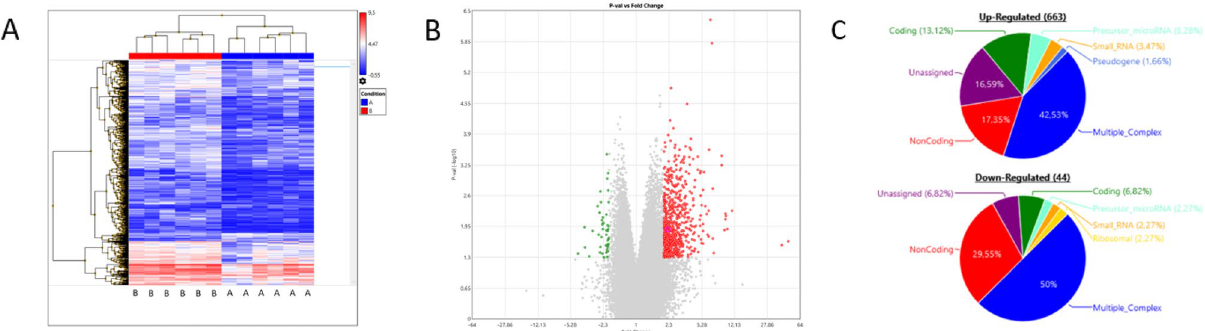
Figure 2. Transcriptome analysis of human embryos cultured in monophasic (5%) O 2 or biphasic (5%-2%) O 2 concentration. ( A ) Heat map. Group A (right part) includes six blastocysts cultured in monophasic (5%) O 2 concentration; Group B (left part) includes six blastocysts cultured in biphasic (5–2%) O 2 concentration. Upregulated genes are in red and downregulated genes are in blue. ( B ) Volcano plot. Each point represents one gene. On the X-axis, the fold change was calculated as the log2-ratio between the mean gene expression in embryos cultured in biphasic (5–2%) O 2 concentration and the mean gene expression in embryos cultured in monophasic (5%) O 2 concentration. Positive and negative values indicate the expression of genes which is higher in embryos cultured in biphasic (5–2%) and monophasic (5%) O 2 concentration, respectively. On the Y-axis, the statistical significance of the difference in gene expression between culture conditions is represented as the (− log10) of the P value. Red and green points mark differentially expressed genes. The thresholds of significance are − 2 and + 2 for downregulated and upregulated genes respectively (x axis), and 1.30 (equal to a P value = 0.05) for the y axis. ( C ) Pie chart of the upregulated (n = 663) and downregulated (n = 44) transcripts in human IVF blastocysts cultured in biphasic (5–2%) O 2 concentration compared with monophasic (5%) O 2